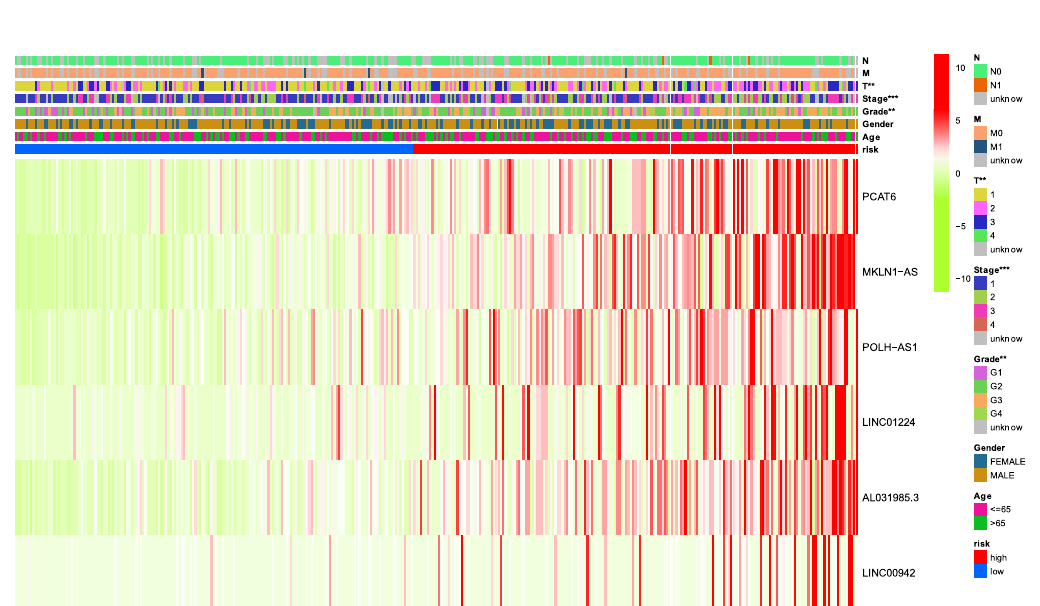
Figure 7. ( A ) A nomogram for both clinic-pathological factors and prognostic ferroptosis-related lncRNAs. ( B ) Heatmap for ferroptosis-related lncRNAs prognostic signature and clinic-pathological